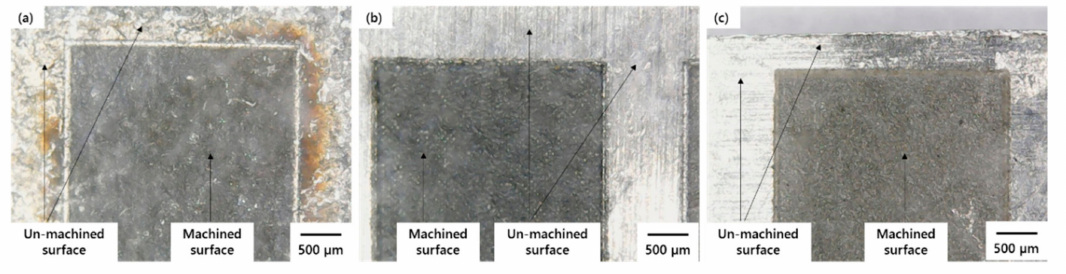
Figure 3. Microscopic enlarged views of laser-milled impression on: ( a ) TiA, ( b ) NiA, and ( c )